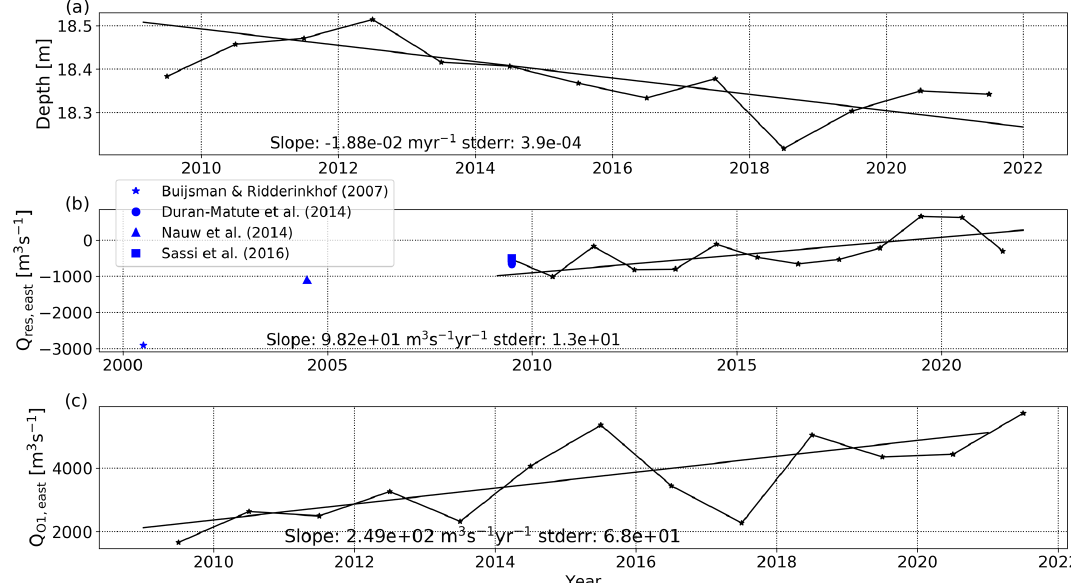
Figure 5. Observed trends after applying harmonic analysis. (a) Annual residual cross-sectionally averaged depth; trend line based on the de-tided time series. (b) Annual residual cross-sectionally integrated eastward volume flux including values reported earlier; trend line based on the de-tided time series. (c) Annual O1 lunar diurnal constituent amplitude of cross-sectionally integrated eastward volume flux; trend line based on the annual amplitudes.